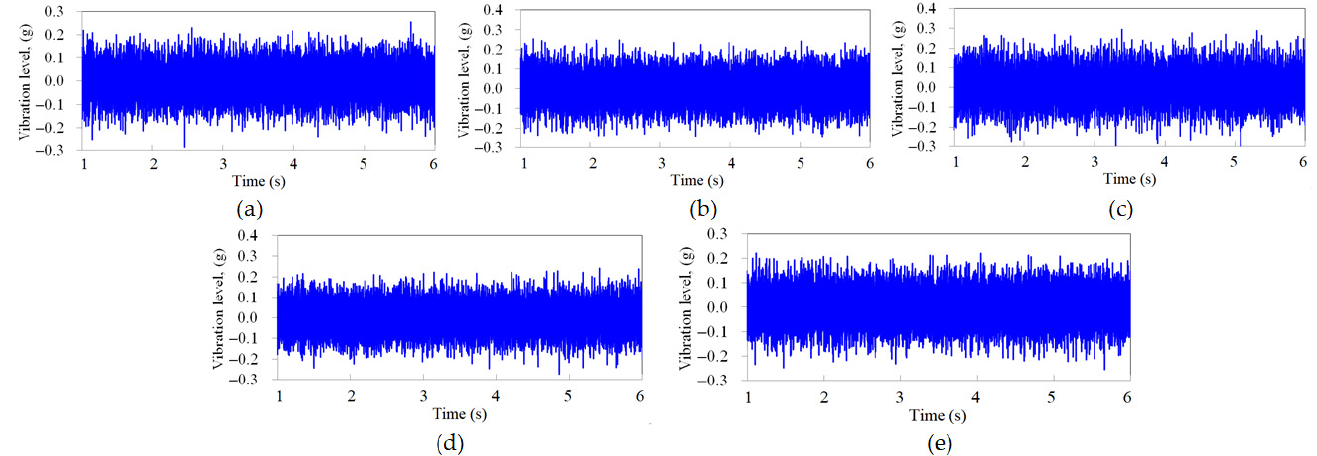
Figure 10. Vibration signals measured at the center of the stage under different preloaded conditions: ( a ) case I—highest rigidity; ( b ) case II—medium rigidity; ( c ) case III—lowest rigidity; ( d ) case IV—high-medium rigidity; ( e ) case V—medium-low rigidity.